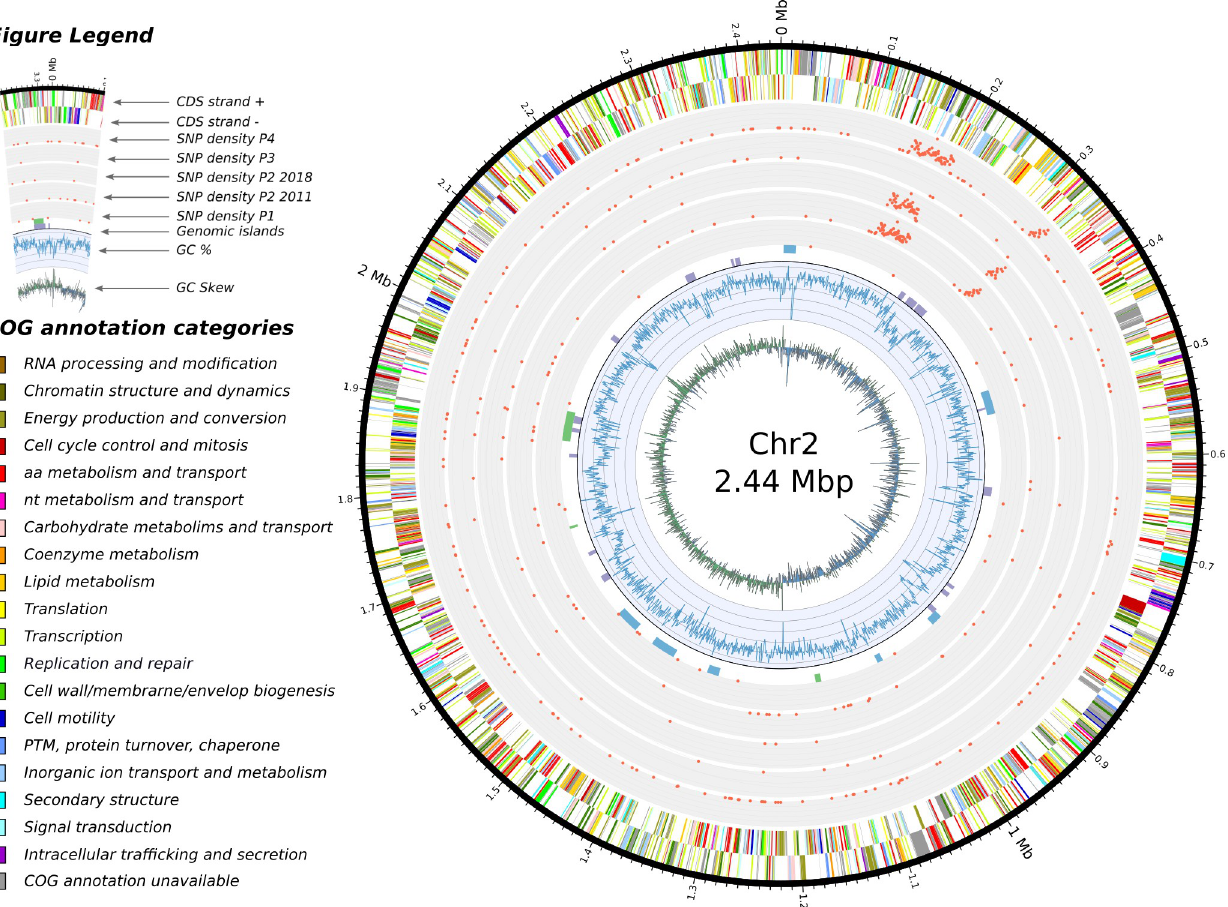
Fig 6. Features of chromosome 2 and SNP densities comparisons. In concentric circles, from the center and outward are depicted: 1) the GC skew, 2) the GC content, 3) the genomic islands detected by the software IslandViewer 4 (in purple), the prophages detected with Phaster (green) and the secondary metabolites identified by antiSMASH (in blue), 4) a total of five SNP densities, we separated the isolates from 2011 and the isolate from 2018 in patient 2 as we regard them as two separate acquisition events, 5) and 6) the annotated features found on the negative and positive strand respectively.